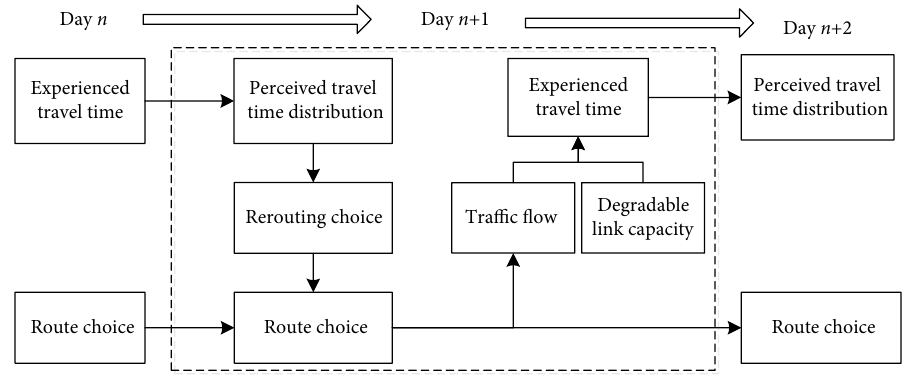
Figure 1: Framework of day-to-day traffic assignment